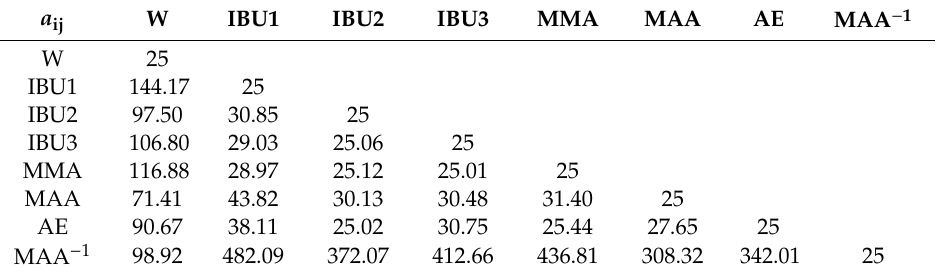
Table 1. Repulsive Parameters Used in DPD Simulations (unit: